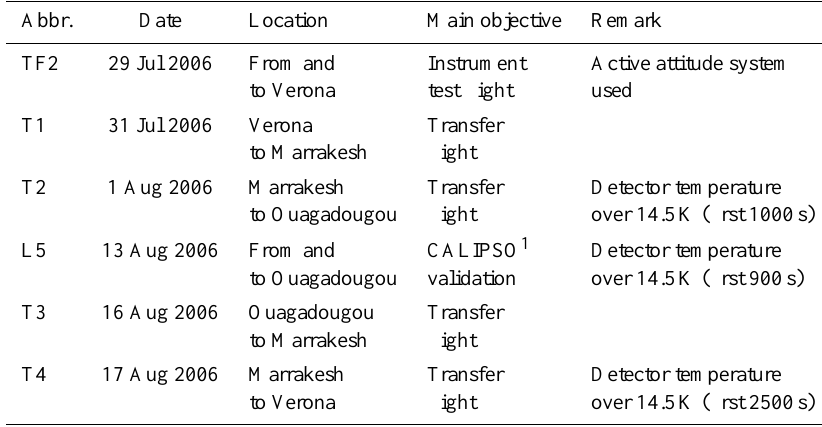
Table 2. CRISTA-NF Level-2 data are available for the following AMMA flights. Abbr.